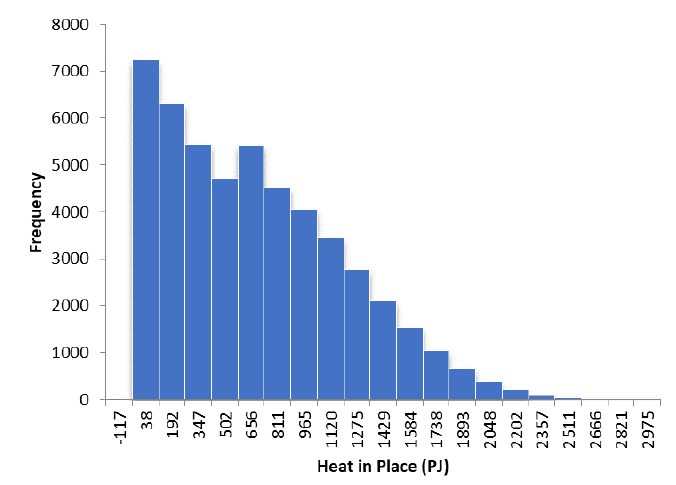
Figure 10. Heat-in-place probability distribution for well doublets—post-rift phase.